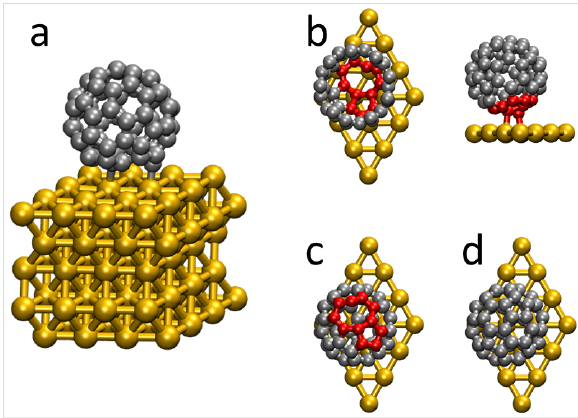
Figure 4: (a) Unit cell used in the calculations. (b) Top and side views of the 8,5-isomer with the single vacancy close to the metal surface. In the top view, the upper C atoms have been removed for clarity. (c) Top view of the 8,5-isomer with the vacancy away from the surface. (d) Ful- lerene with no defects (C 60 ). Carbon atoms around the vacancy are shown in